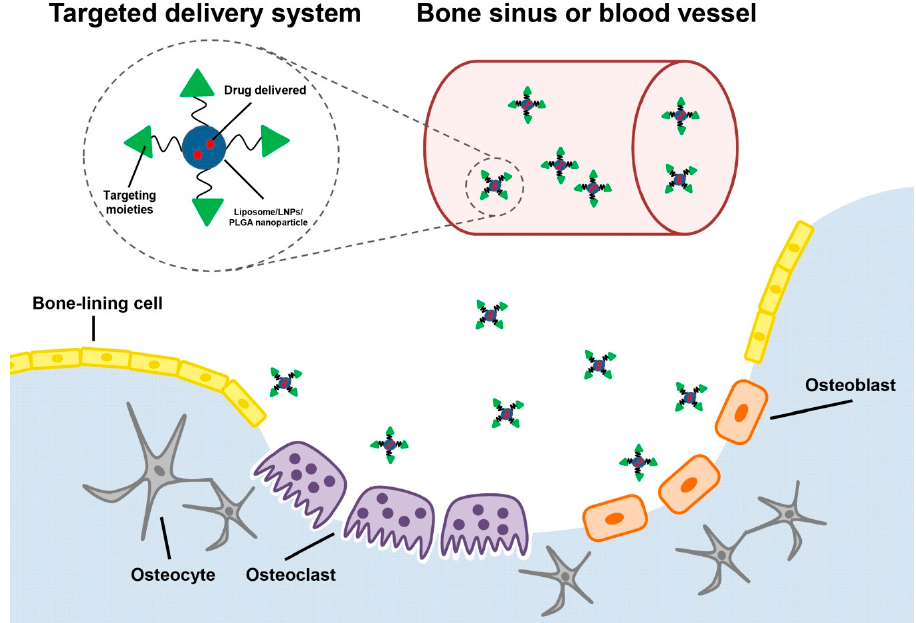
Figure 1. The schematic graph of targeted delivery systems carrying drugs extravasated from bone sinusoid or blood vessels to different target cells in bone. The targets for drug delivery depend on the targeting moieties in the targeted delivery systems.